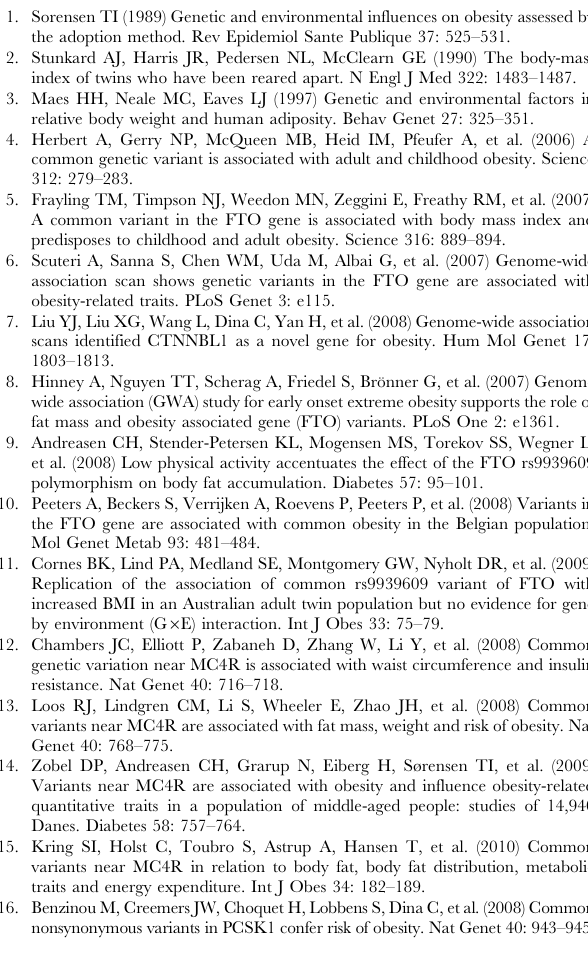
Table S1 Clinical characteristics of the study groups comprising the combined study population. Table S2 Statistical power calculations in replication case-control settings.